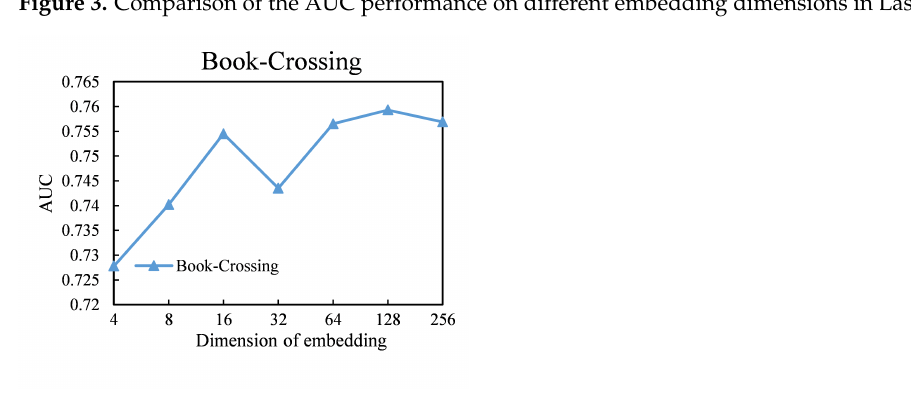
Figure 4. Comparison of the AUC performance on different embedding dimensions in